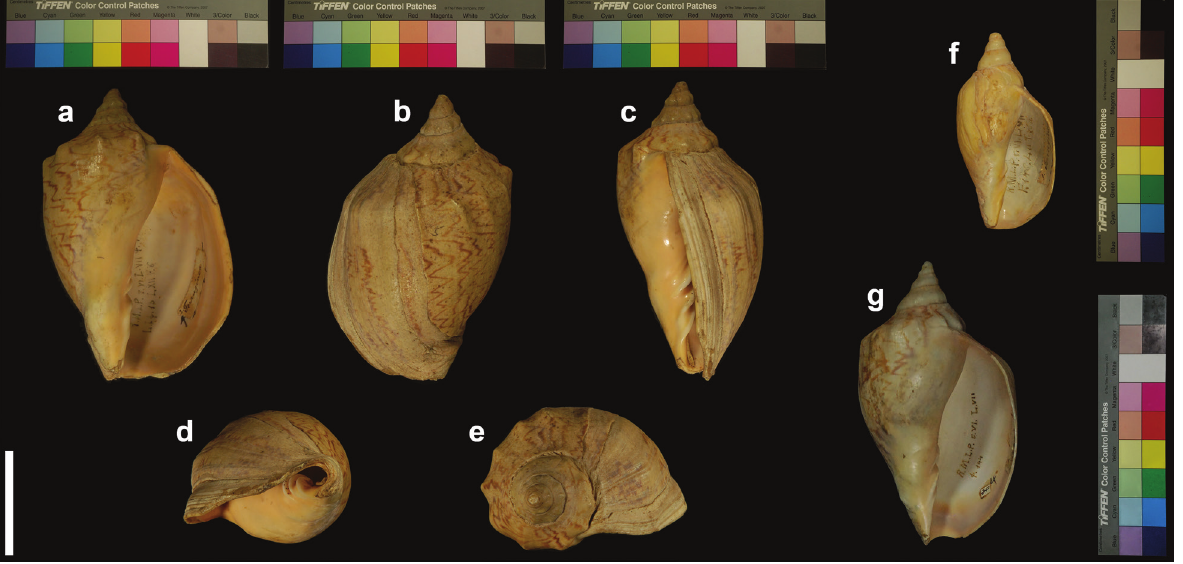
Lahille (1895) described the shells as elongate, with the last whorl large and ovoid, and with few tubercles. The penultimate whorl is convex and without tubercles. Voluta tuberculata pseudofusiformis Lahille, 1895 Holotype: MLP-Ma 10894, 125.5 mm long × 71.5 mm wide, figured by Lahille (1895: pl. XII, fig. 7); label reads: “4. Pseudo-fusif (2°S)” (Fig. 54).